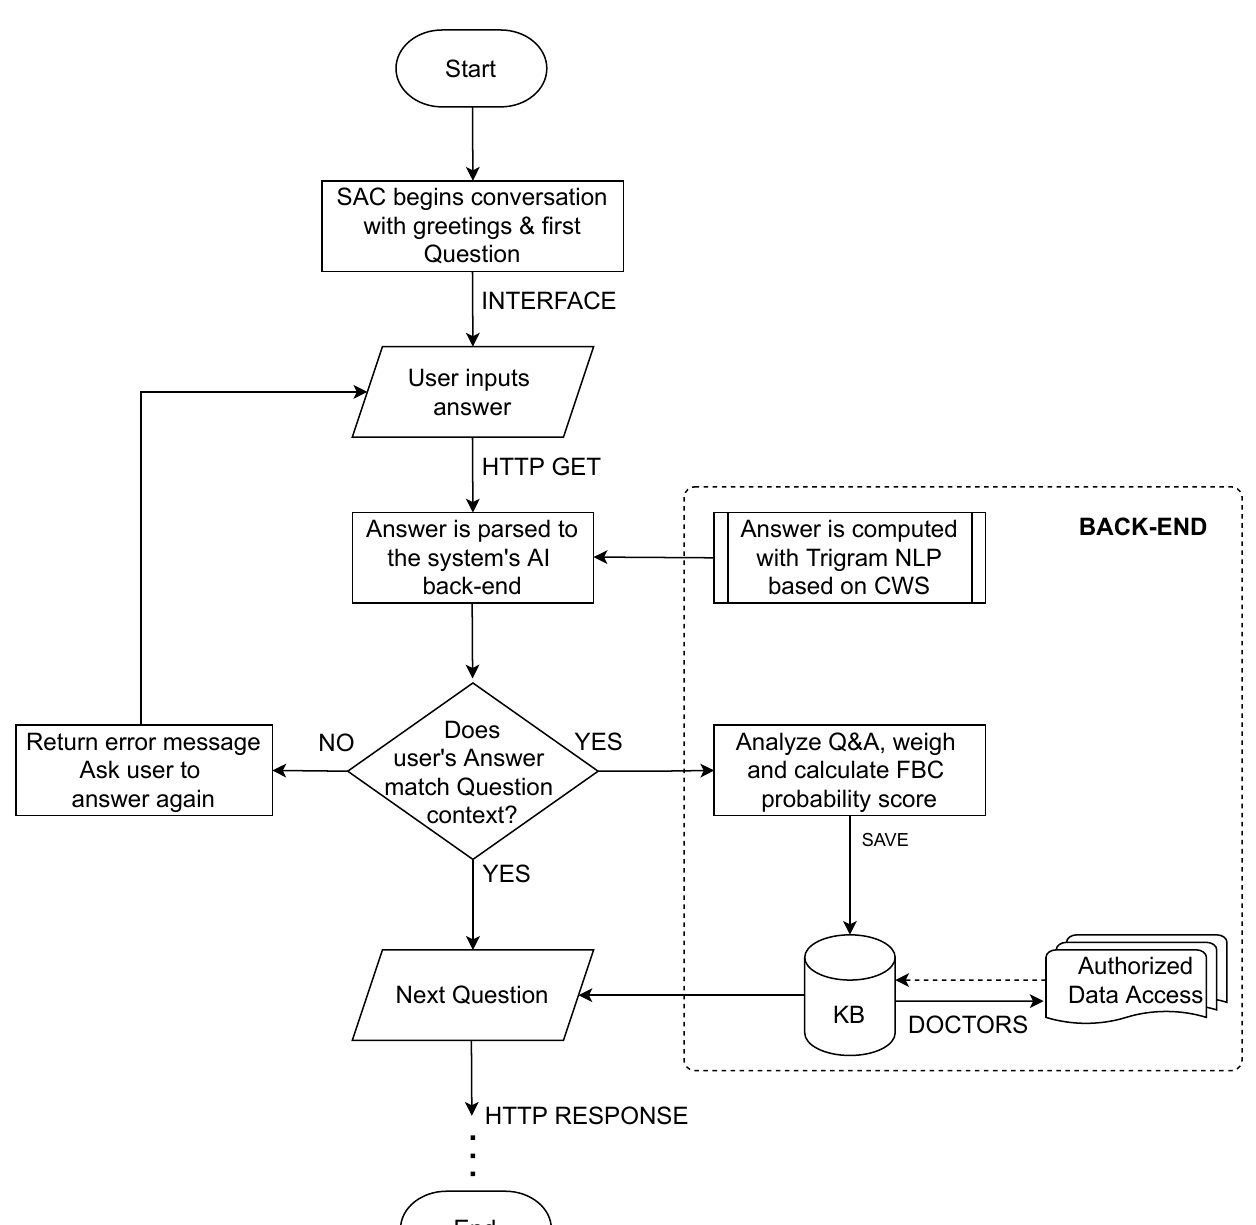
Figure 3. The dialog information flow process of the SAC